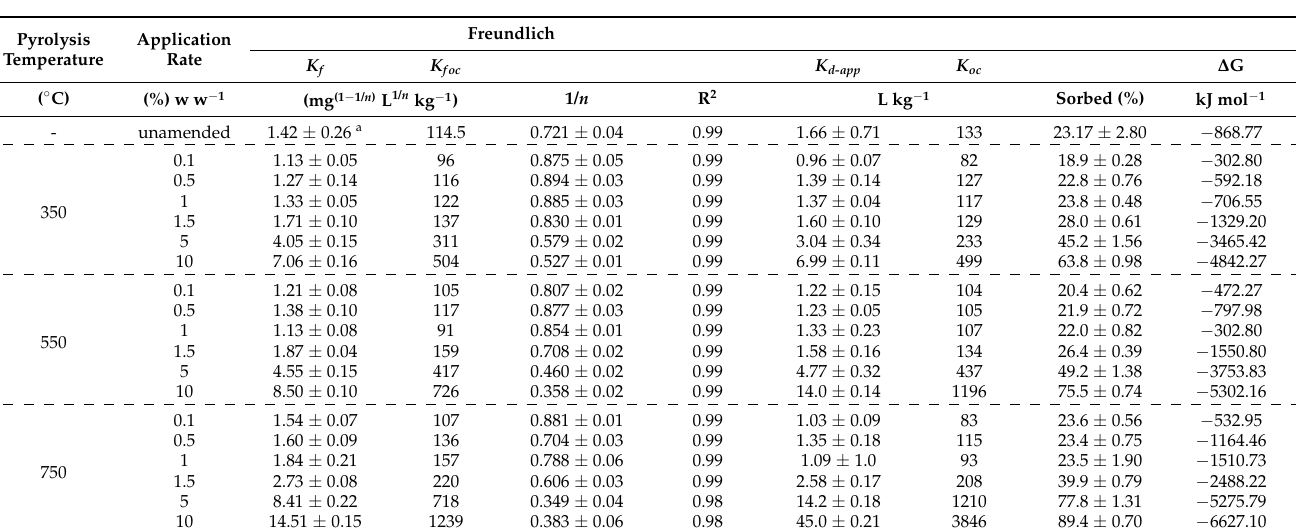
Table 3. Sorption isotherm parameters of Freundlich model. Sorption coefficient ( K d - app ) of 2 mg L − 1 and Gibbs free energy ( ∆ G) concentration for metribuzin applied to soil amended with sugarcane straw biochar and unamended soil.